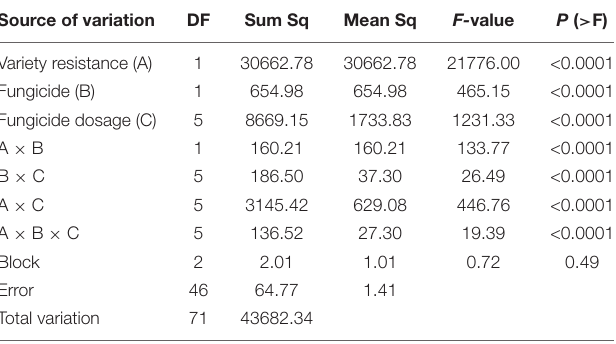
TABLE 3 | Multiple factor analysis of mildew under different active ingredient dosages of two fungicides on two varieties in 2018/19 season. Source of variation Mean Sq F- value Variety resistance